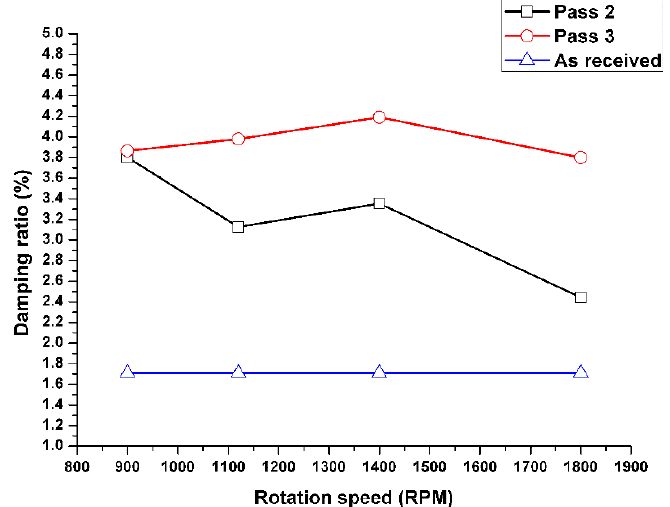
Figure 12. Effect of multi-pass FSP on the damping capacity of the surface composite matrix at a tool rotation speed of 1400 rpm and feed rate of 10 mm/min.